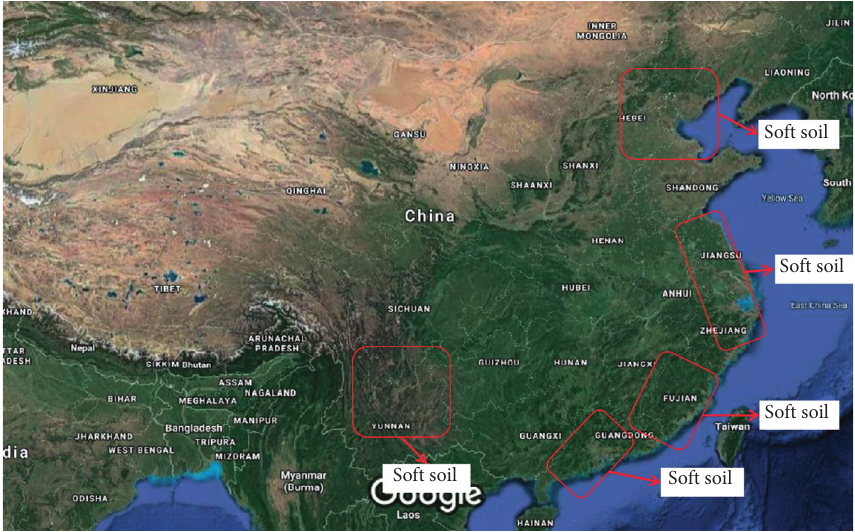
Figure 1: Distribution of soft soil ground in